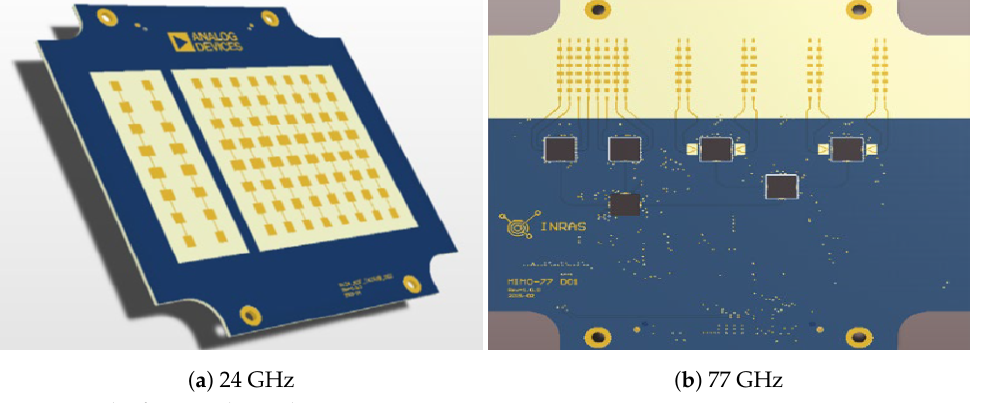
Figure 5. The front-ends used in our experiments. Table 1. The details of the INRAS radar for the front-ends at 24 GHz and 77 GHz.